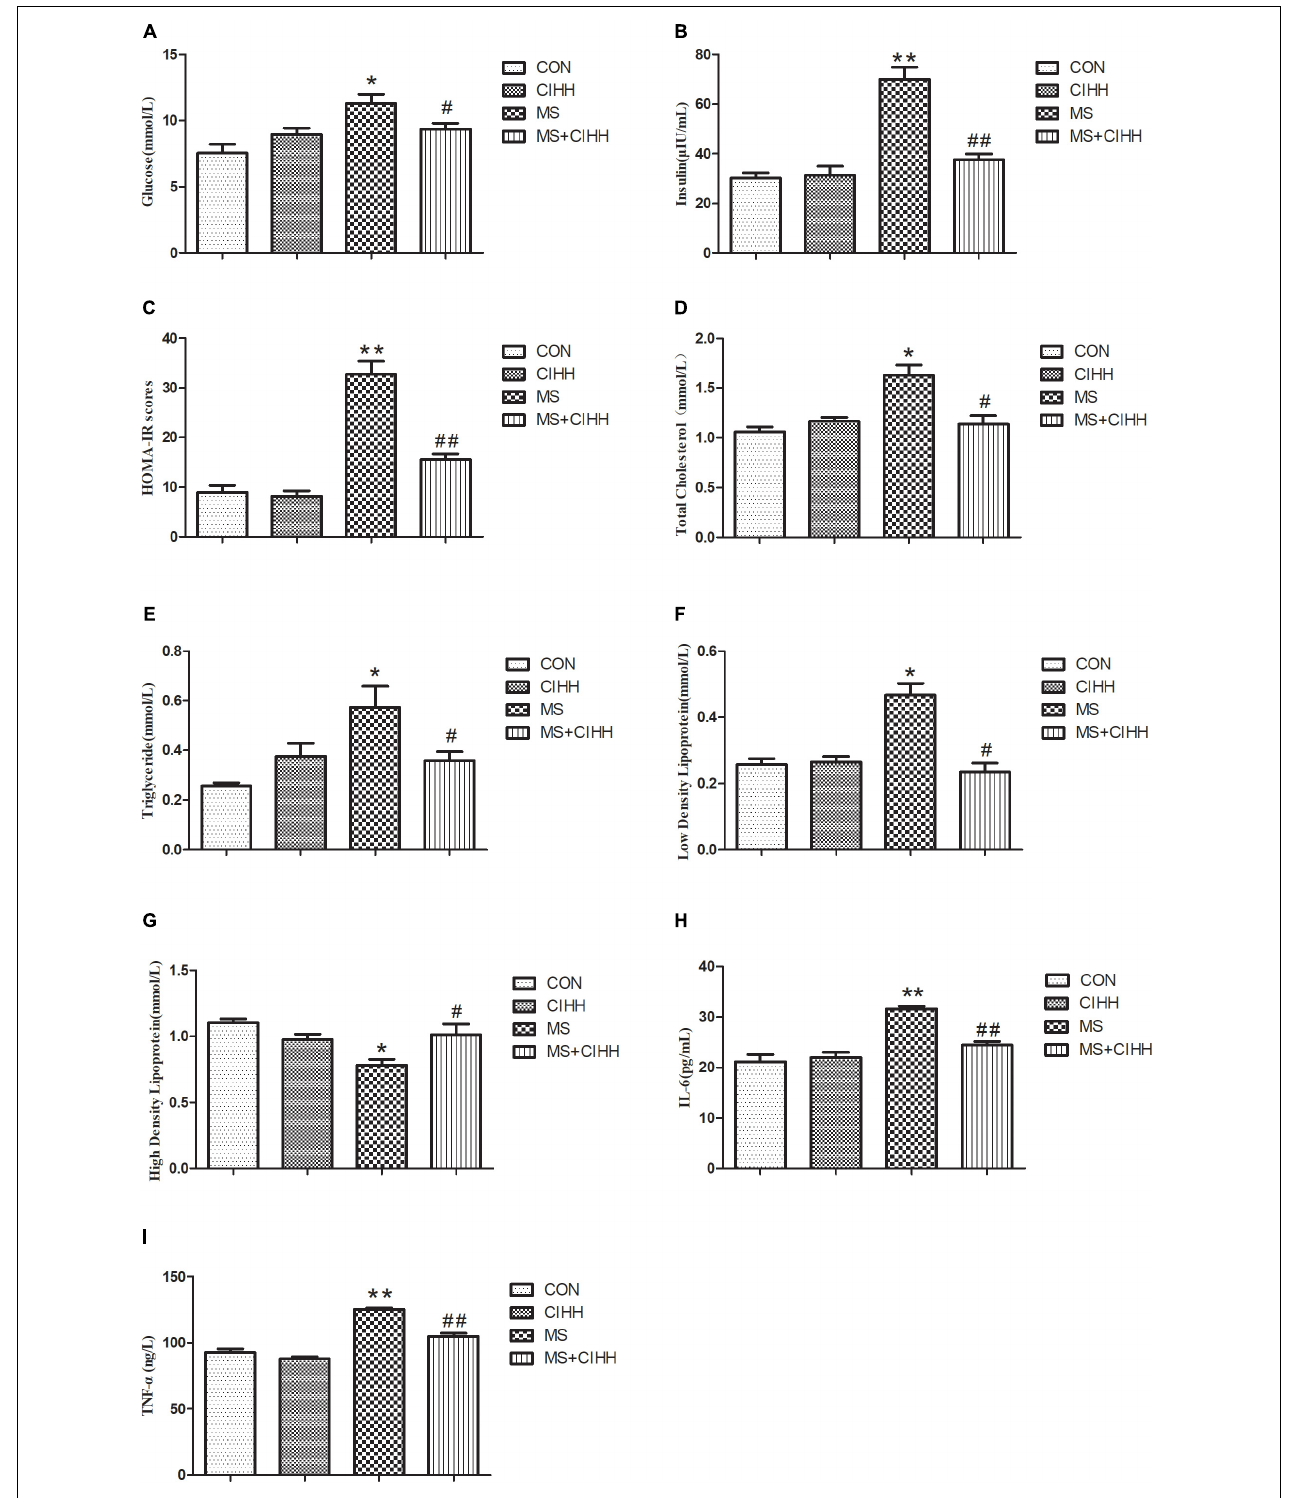
FIGURE 2 | The effect of CIHH on blood biochemical parameters. (A) The effect of CIHH on glucose. (B) The effect of CIHH on insulin. (C) The effect of CIHH on homeostatic model assessment-insulin resistance (HOMA-IR) scores. (D) The effect of CIHH on total cholesterol. (E) The effect of CIHH on triglyceride. (F) The effect of CIHH on low density lipoprotein. (G) The effect of CIHH on high density lipoprotein. (H) The effect of CIHH on interleukin 6 (IL6). (I) The effect of CIHH on tumor necrosis factor- α (TNF- α ). CON: control group, CIHH: CIHH group, MS: Metabolic syndrome group, MS + CIHH: MS + CIHH group. All data were expressed as mean ± SD; n = 6 for each group. * P < 0.05 ** P < 0.01 vs. CON, # P < 0.05 ## P < 0.01 vs. MS.